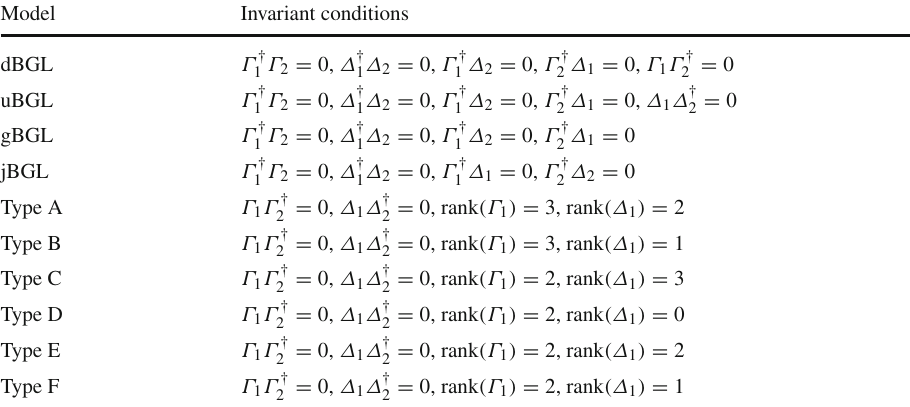
Table 5 Summary of